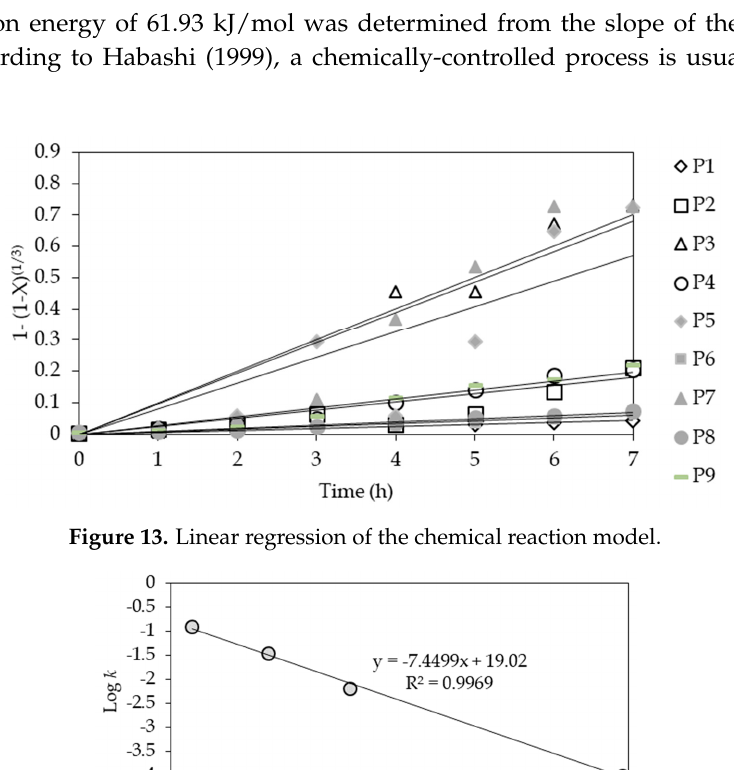
Table 10. Results for the linear regression of the chemical reaction model of all 10 tests.